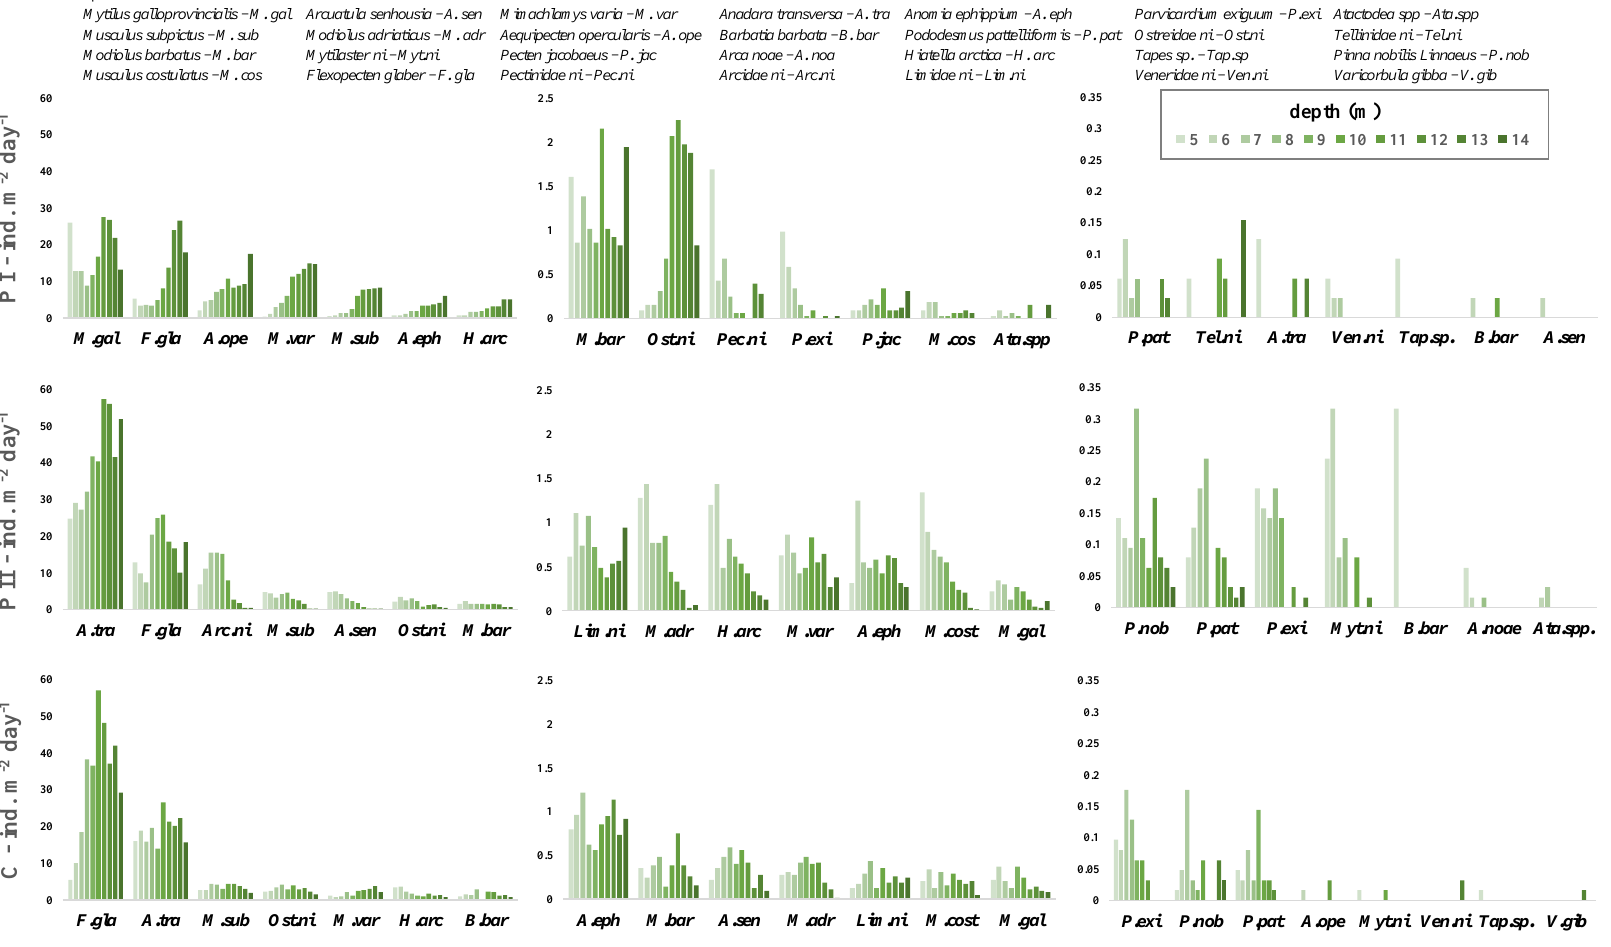
Figure 6. Settlement rates of each taxon at the various depths over the three sampling surveys: Pellestrina I ( PI ), Pellestrina II ( PII ) and Caleri ( C ). From left to right, taxa with decreasing total abundance are shown. Note the different scales on the y-axes.